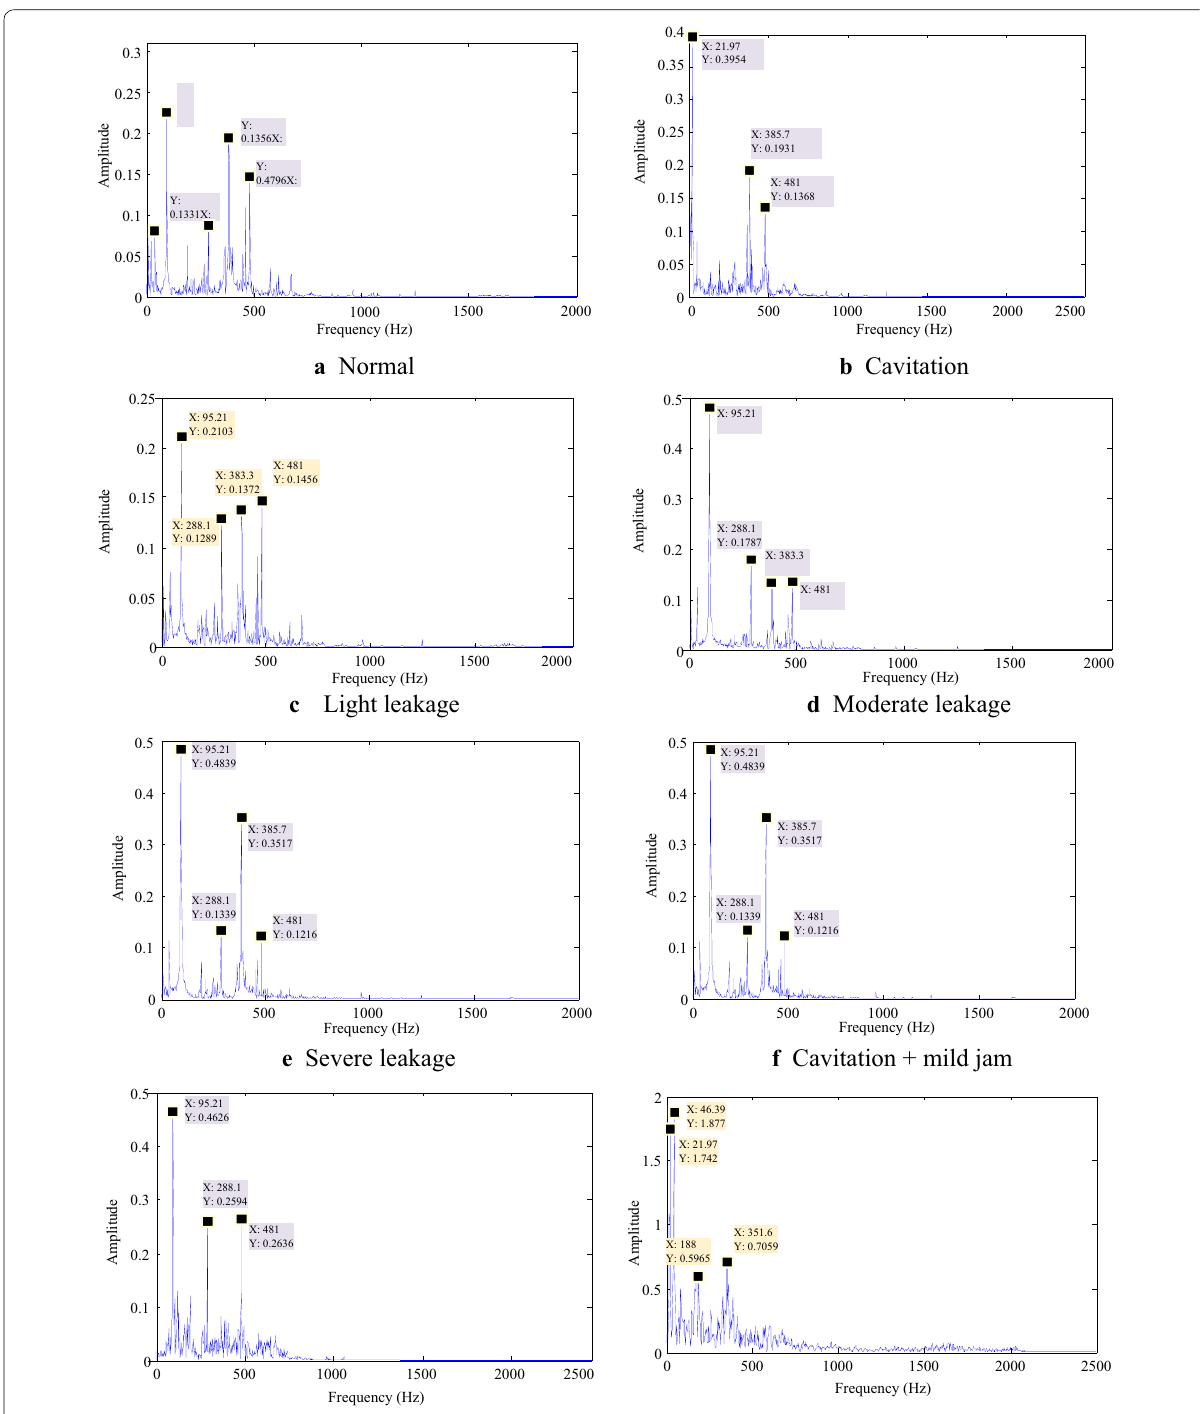
Figure 2 Marginal Hilbert spectrum of various types of hydraulic fault